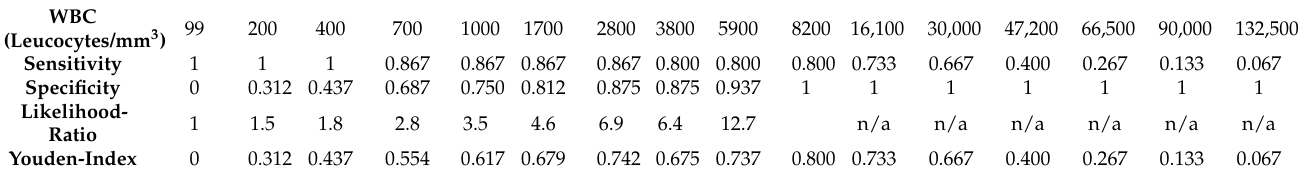
Table 3. Sensitivity, specificity, Youden index and positive likelihood ratio for different WBC